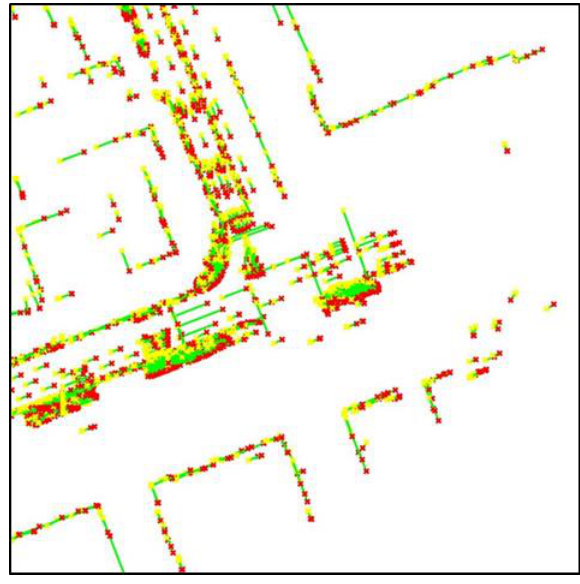
Figure 19. ELM in area of interest. Sensors 2018 , 16 , x FOR PEER REVIEW